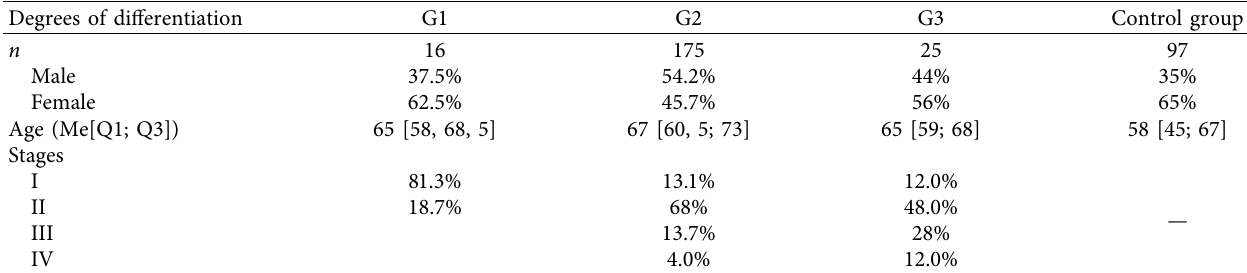
Table 1: Characteristics of patients in the experimental group.